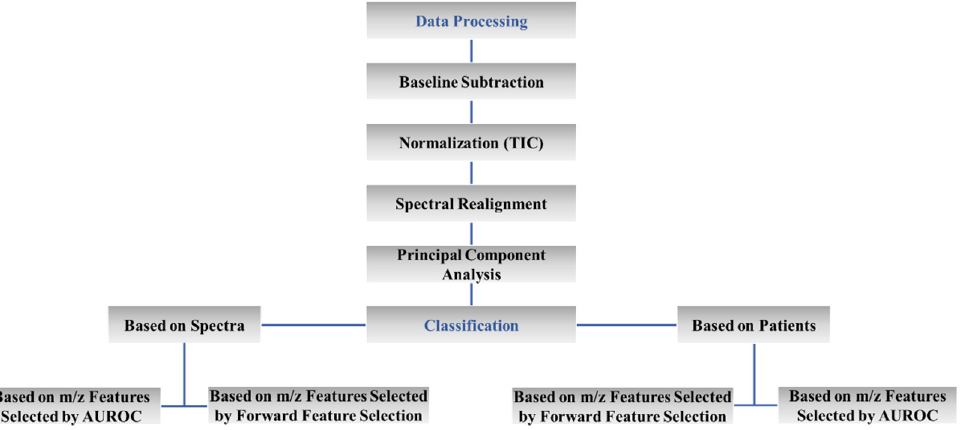
Figure 2. Summary of the data analysis workflow .